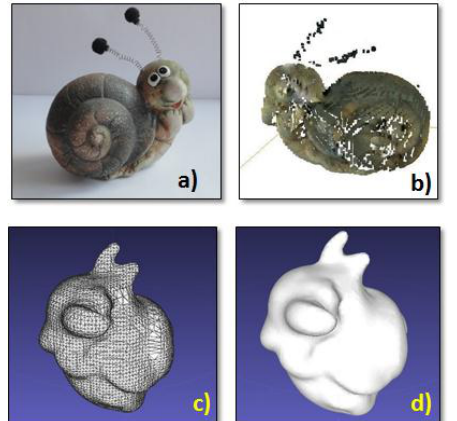
Figure 9. Snail figurette: a) photo of the real object; b) scanned cloud of points; c) processed data in form of TIN surface; d) 3D model